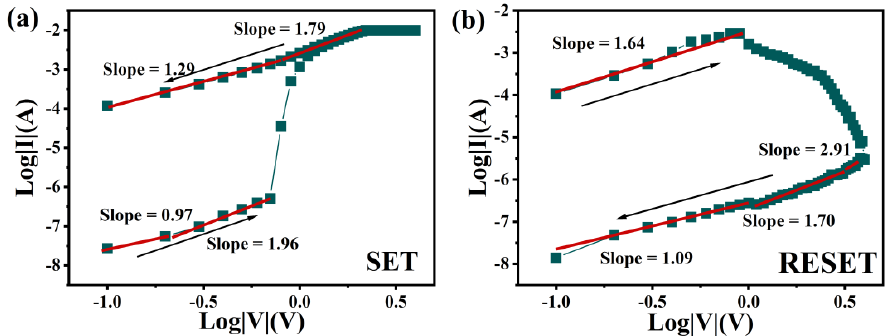
Figure 6. Log(V) – Log(I) fitting diagram of Au/HfO 2 /Al-ZnO/HfO 2 /ITO device: ( a ) set operation, and ( b ) reset operation.